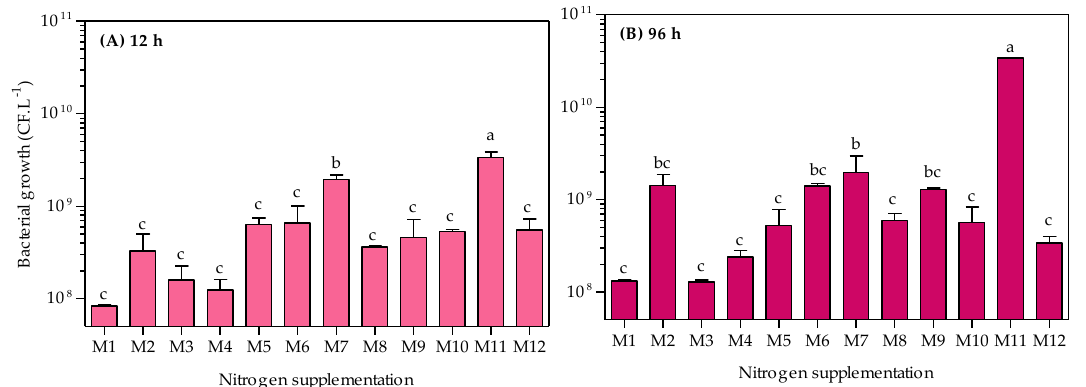
Figure 2. Comparative effect of nitrogen supplementation (viz. M1–M12) on the growth of Aeromonas caviae CHZ306. M1 (ammonium sulfate), M2 (ammonium acetate), M3 (ammonium nitrate), M4 (urea), M5 (casaminoacids), M6 (meat extract), M7 (yeast extract), M8 (peptone Bacto), M9 (pep- tone A), M10 (peptone G), M11 (corn-steep solids), and M12 (tryptone). All data represent the mean ± standard deviation (sd). Different letters indicate statistical differences among columns at the same time ( p < 0.05).